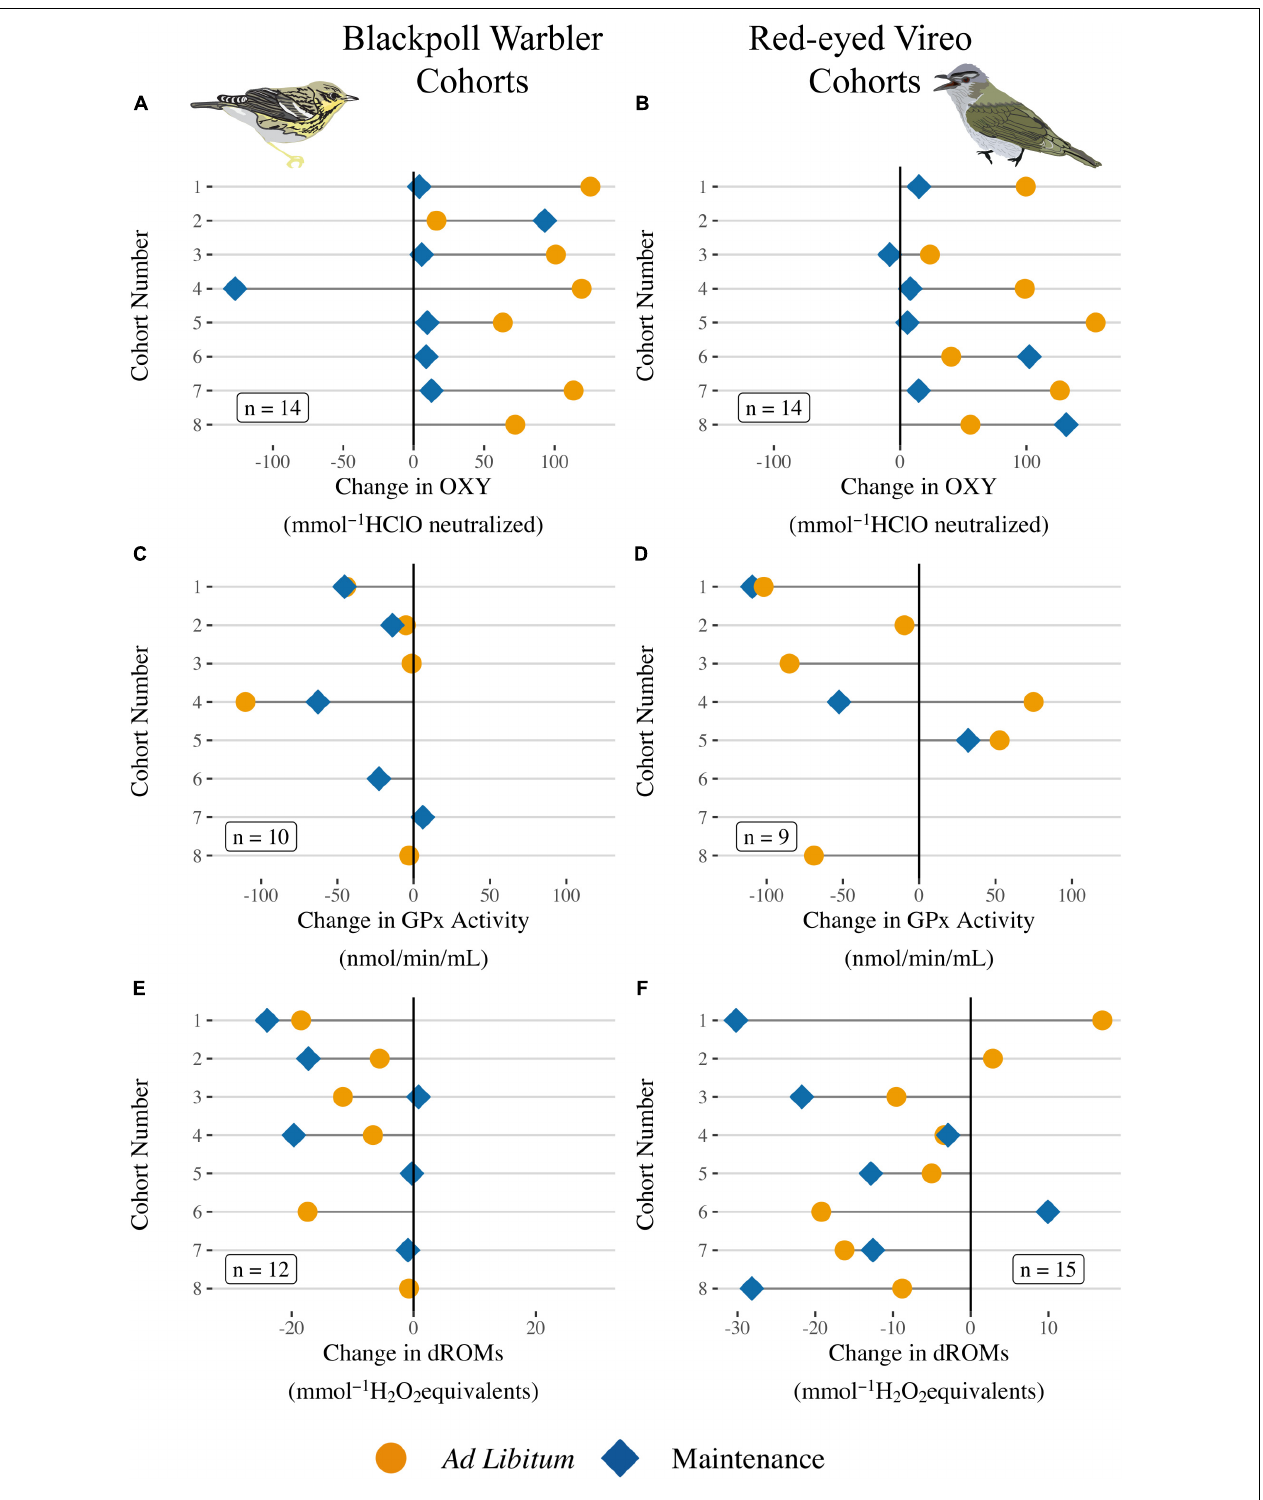
FIGURE 3 | (A,B) Change in plasma non-enzymatic antioxidant capacity (OXY), (C,D) erythrocyte glutathione peroxidase activity (GPx), and (E,F) plasma oxidative damage (dROMs) for each individual fed ad lib (gold circles) or at maintenance levels (light blue diamonds) during captivity by cohort. Cohorts caught later in the season have higher numbers. Each dot represents an individual and the line indicates the magnitude of change during captivity (sample at release—sample at capture). Labels indicate samples sizes for each oxidative measurement per species.